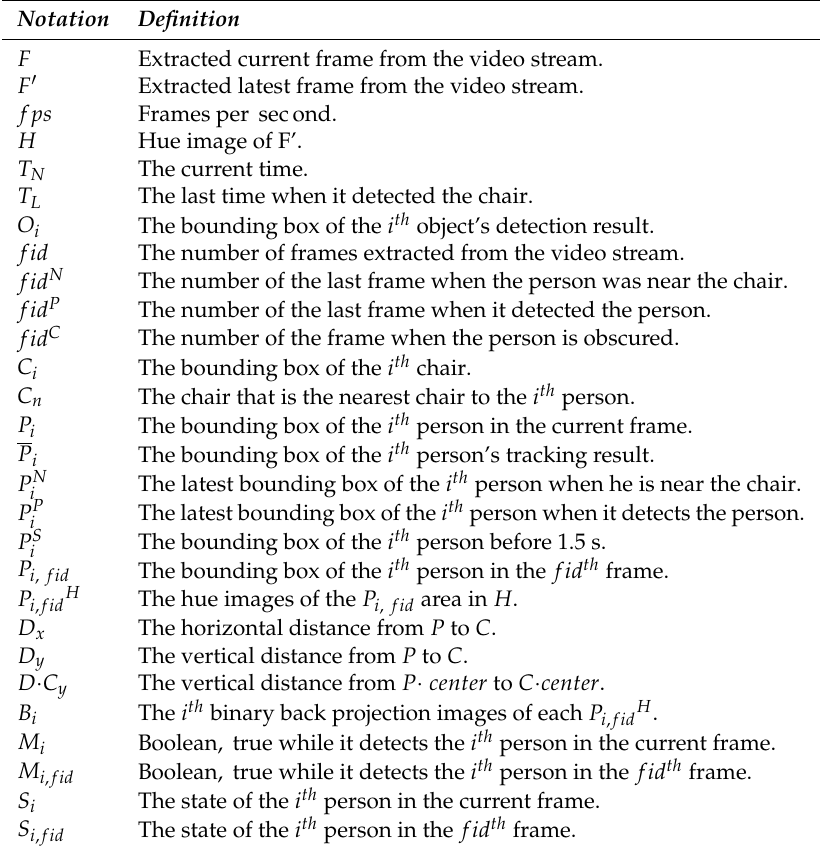
Table 1. List of notations and